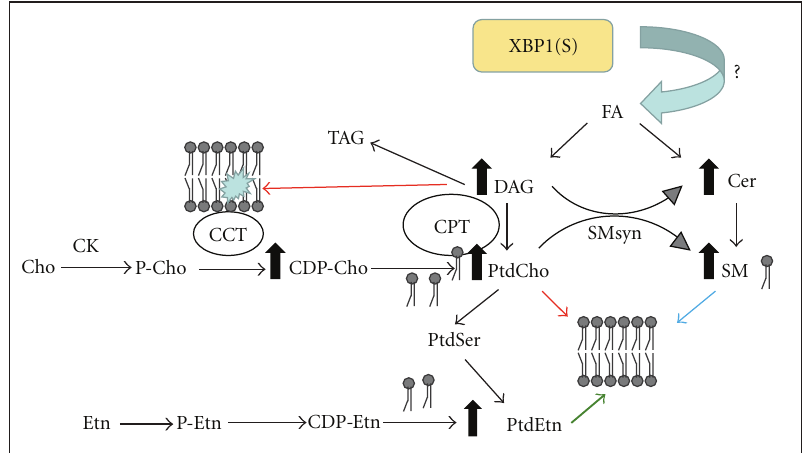
Figure 1: Activation of membrane phospholipid synthesis. Expression of XBP1(S) stimulates de novo fatty acid (FA) synthesis and the new FAs are incorporated into diacylglycerol (DAG) and ceramide (Cer), immediate precursors of phosphatidylcholine (PtdCho), and sphingomyelin (SM) phospholipids, respectively. The mechanism of stimulation by XBP1(S) has not yet been defined. Elevation of the DAG level alters the membrane lipid composition which leads to activation of the choline cytidylyltransferase (CCT) enzymes which produce CDP-choline (CDP-Cho). The DAG and CDP-Cho precursors are converted to PtdCho by the choline phosphotransferase (CPT) enzymes. Excess DAG which is not incorporated into phospholipid, is redirected and incorporated into triacylglycerol (TAG) which can accumulate in lipid droplets. PtdCho conversion to SM is mediated by sphingomyelin synthase (SMsyn). PtdCho conversion to phosphatidylethanolamine (PtdEtn) is routed through phosphatidylserine (PtdSer). PtdEtn can also be synthesized from ethanolamine (Etn) and DAG by the alternative CDP-ethanolamine (CDP-Etn) pathway. Elevation of all three phospholipids, PtdCho, SM, and PtdEtn, contributes to membrane biogenesis during B cell activation. Cho, choline; P-Cho, phosphocholine; CK, choline kinase; Etn, ethanolamine; P-Etn,